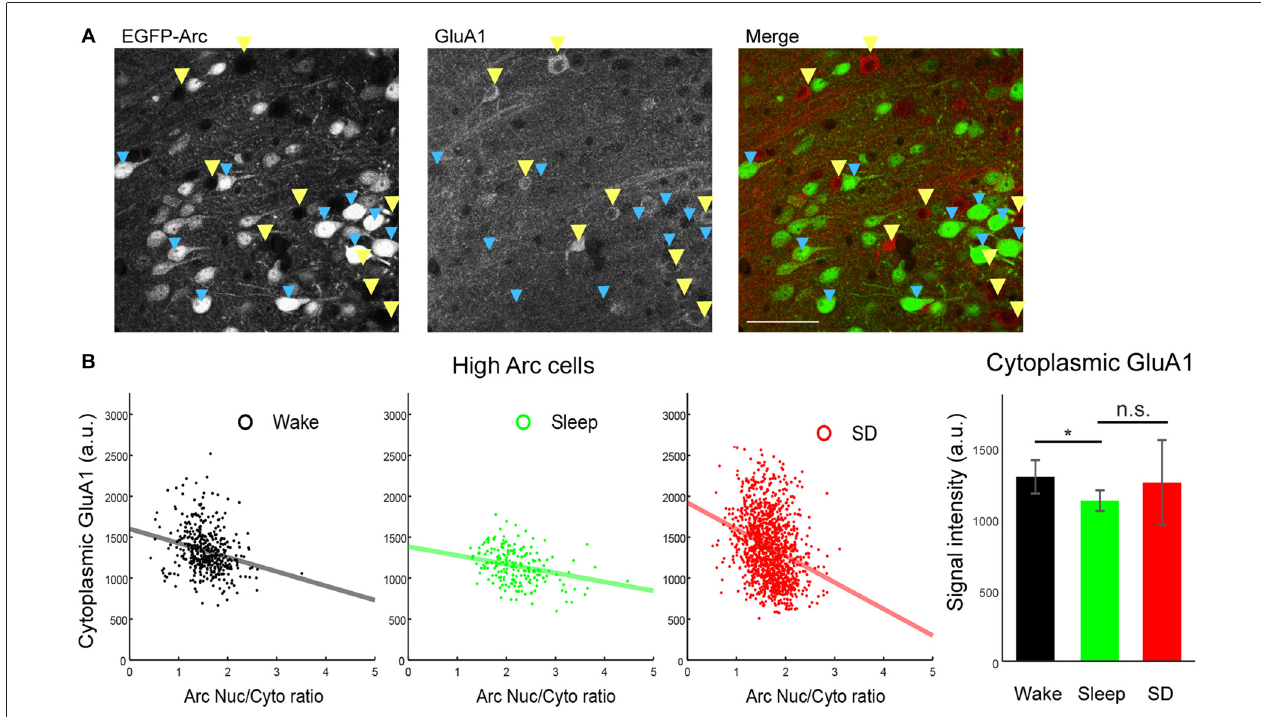
FIGURE 4 | Negative correlation between Arc Nuc/Cyto and cytoplasmic GluA1 levels in High Arc neurons of Cg1 superficial layers. (A) Representative images of double-staining of EGFP-Arc and GluA1 in Cg1 (SD mouse). Blue arrowheads: High Arc neurons, yellow arrowheads: Arc negative neurons. (B) Left, negative correlation between Arc Nuc/Cyto and cytoplasmic GluA1 signal. All neurons analyzed are shown. Right, mean and standard deviation of cytoplasmic GluA1 levels. ∗ p < 0.05, unpaired t -test using mean value of each mouse.